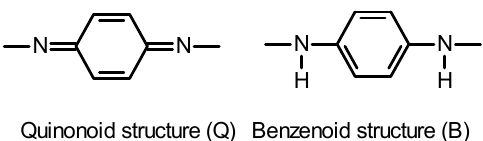
Figure 3. The quinonoid and benzenoid structures in the main chain of PANI.